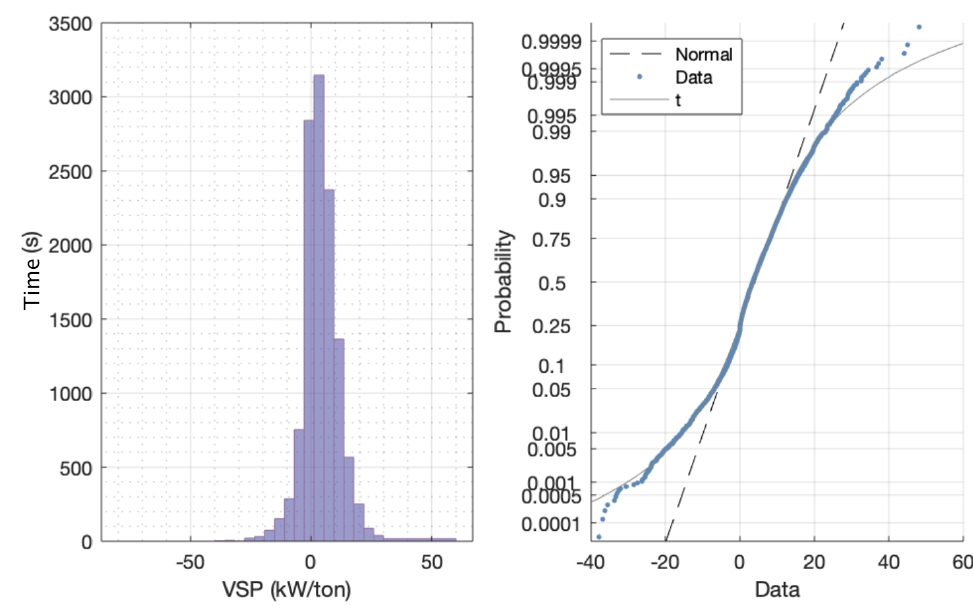
Figure 7. Histogram and probability plot for tests using gasohol E7.8.